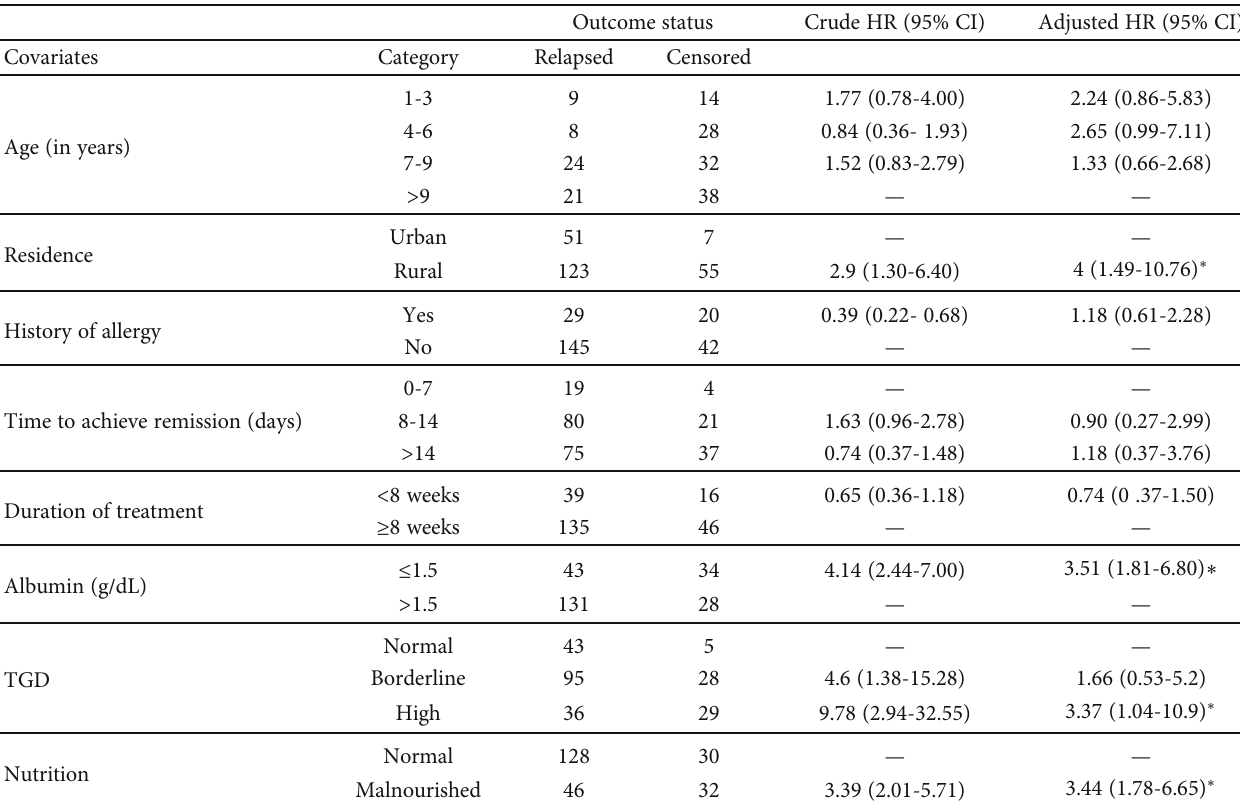
Figure 2: Overall Kaplan-Meier relapse estimate among children with nephrotic syndrome in comprehensive specialized hospitals of Tigray region, Northern Ethiopia, 2019 ( N = 174 ). The y -axis represents the probability of relapse whereas the x -axis indicates the analysis time in months. Table 4: Bivariable and multivariate analysis output for children with nephrotic syndrome in comprehensive specialized hospitals of Tigray region, Northern Ethiopia, 2019 ( N = 174